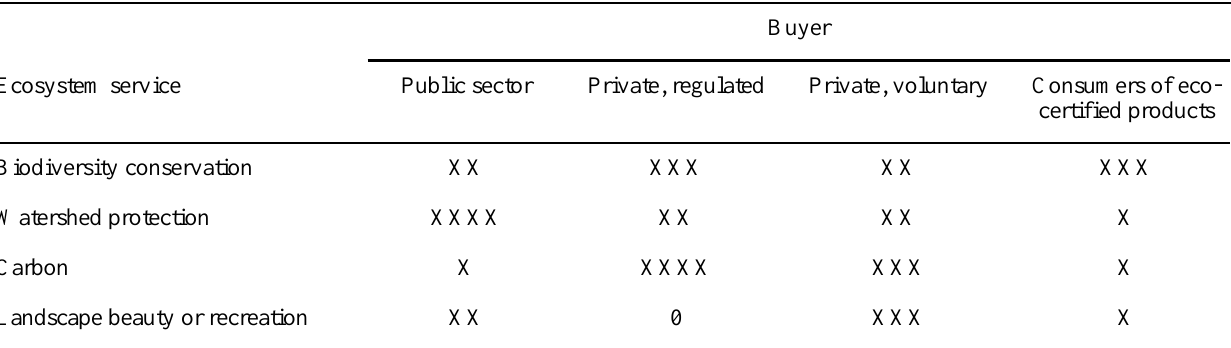
Table 2. Potential for each market sector of payment for ecosystem services to benefit low-income households and communities in developing countries within the next two decades.†